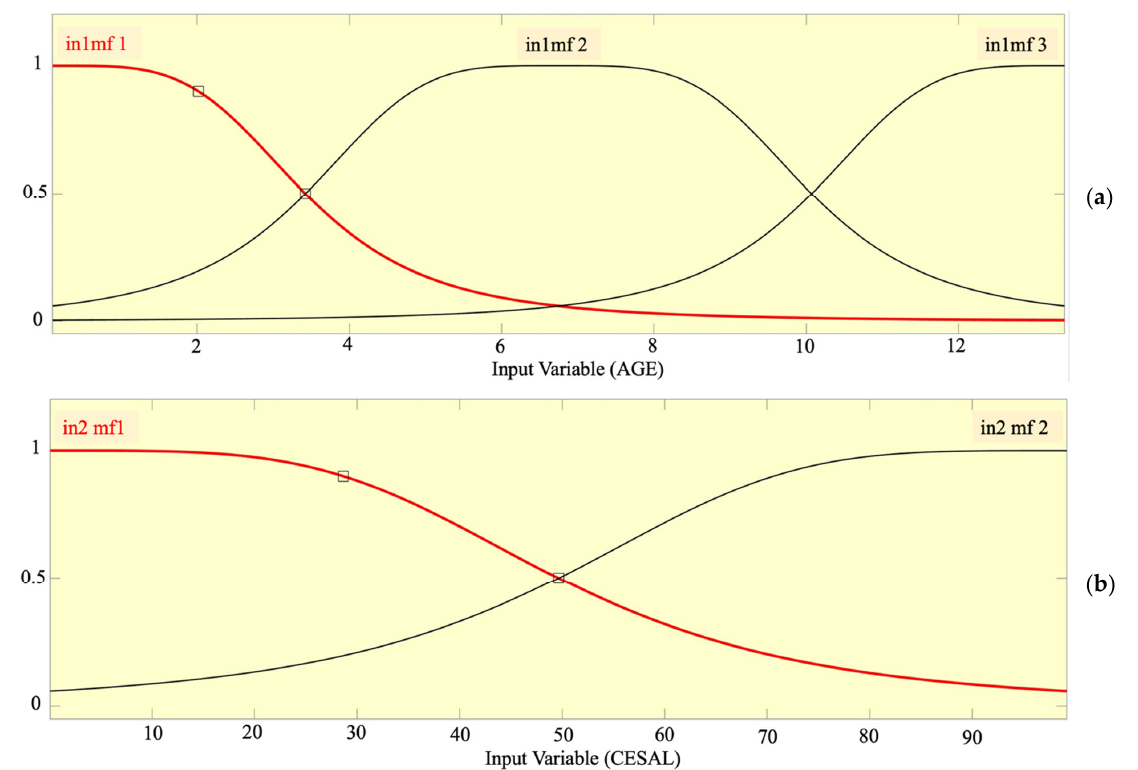
Figure 7. Initial MFs for DBST input variables of ( a ) AGE and ( b ) CESAL.